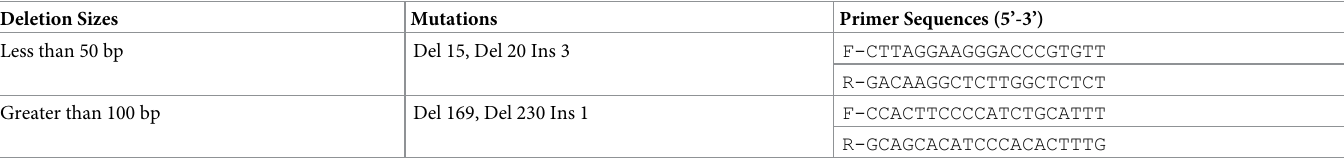
Table 1. Sequences of primers used for genotypic analysis of the four Hamp KO rat lines. Deletion